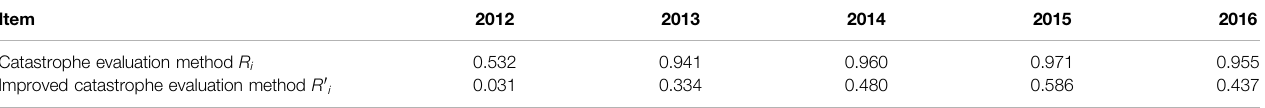
TABLE 4 | Comprehensive development level of reclaimed water calculated with the improved catastrophe assessment